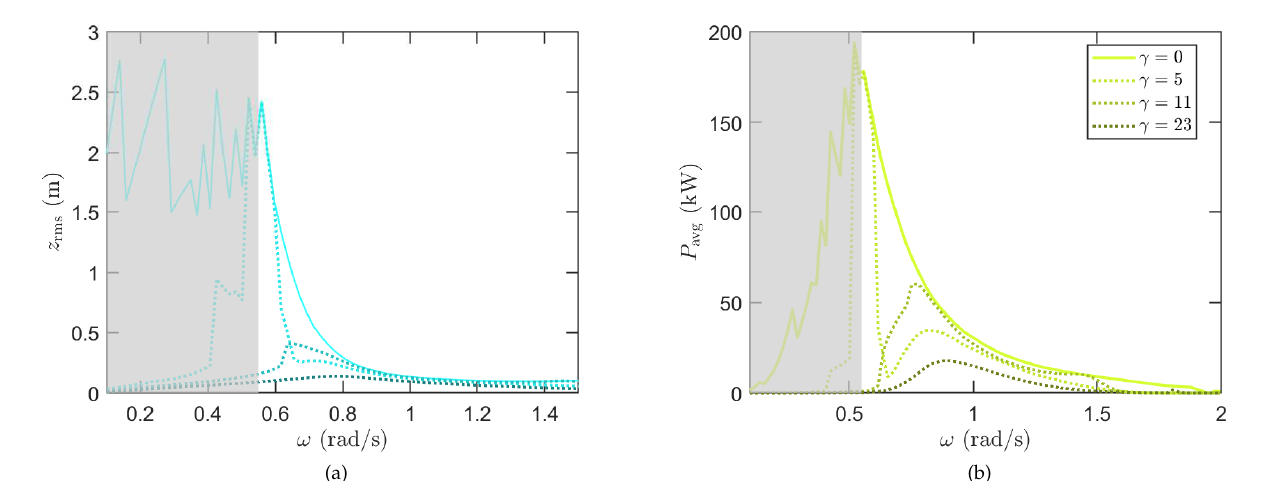
Fig. 7. The resulting peak motion (7a) and the time-averaged power (7b) for the 1-DOF scenario and varying γ , using PTO parameters found from (8). The damping of the PTO was increased for frequencies below 0 . 54 rad / s to prevent breaching; therefore, these results may be considered only near optimal (region shaded).